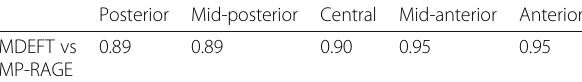
Table 4 Intraclass correlation coefficients of callosal morphometric